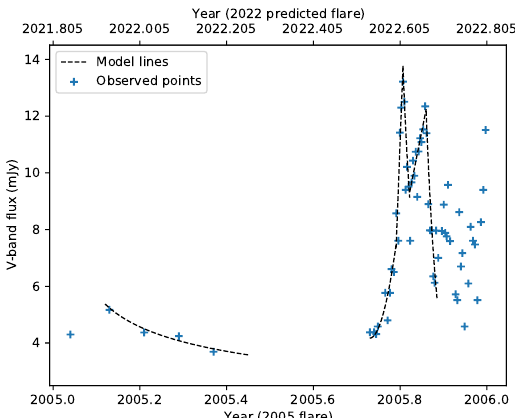
Figure 4. The optical light curve of OJ 287 during 2005 in V-band mJy units. Plot shows the monthly averaged data points for the early part of 2005 while the latter part, with faster variability, has 3 day averaged data points. The dashed curve is the theoretical line based on present work and Valtonen et al. [87]. Additionally, the theoretical curve provides the expected light-curve of OJ 287 during 2021–2022 and we mark its epochs on the upper x-axis while employing the time shift of the SMBH binary central engine description Dey et al. [33]. This is motivated by the fact that the secondary BH impact distances from the center should be roughly the same during 2005 and 2021. The first big flare during 2022 is not expected to be visible from any Earth-based facility while the secondary peak may become barely visible by early September